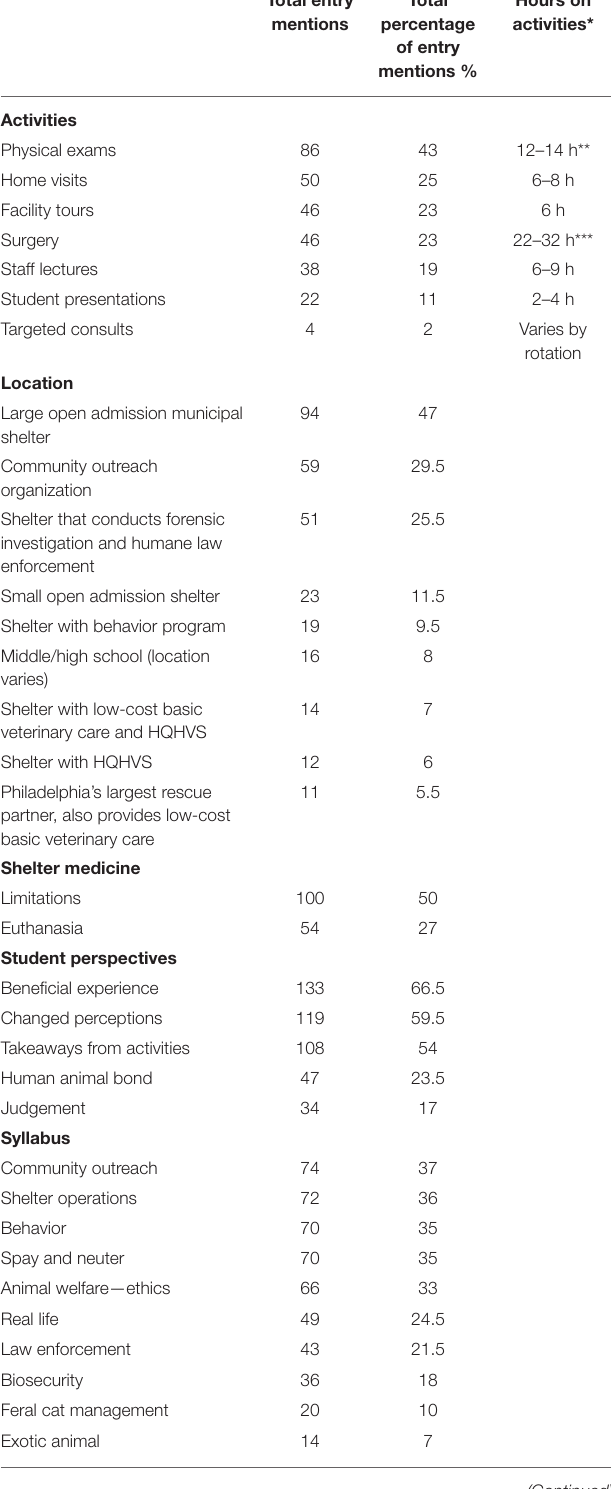
TABLE 2 | Quantification of the total journal entry mentions for each node, the percentage of journal entry mentions for each node as a percentage of the total journal entries, and an approximation of hours spent on each activity throughout the